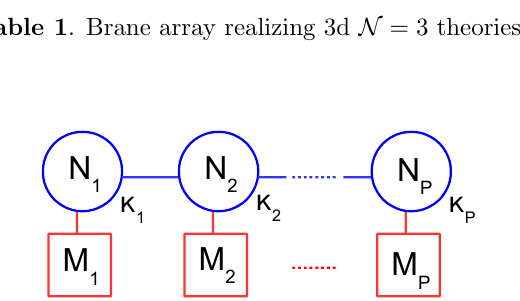
Figure 1 . N = 3 linear quiver diagram. The labels (cid:20) i indicate the CS